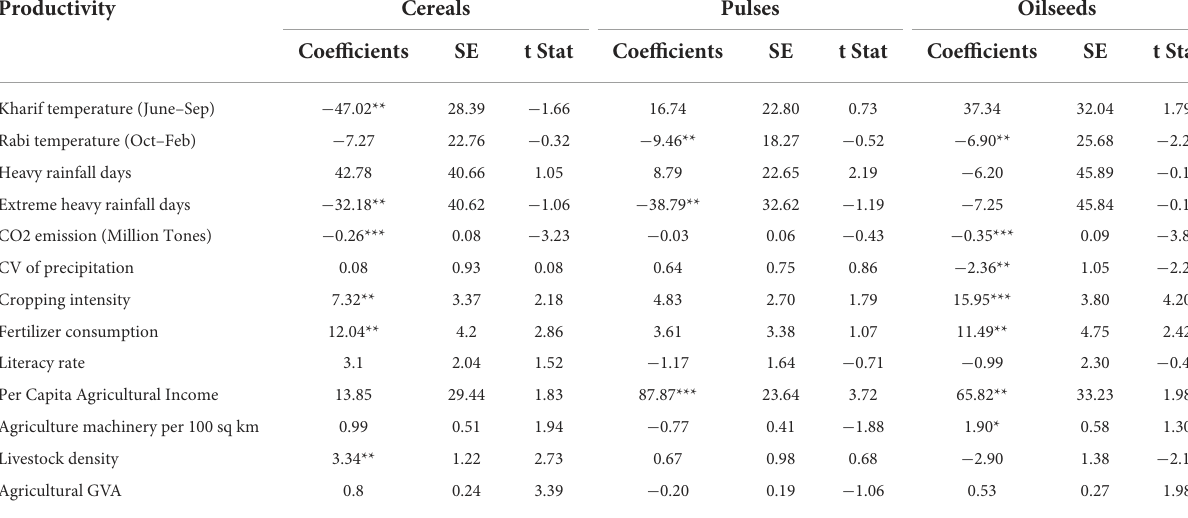
TABLE 2 Impact of change in climatic parameters on productivity of cereal, pulse and oilseed crops through Tobit regression model. Productivity Cereals Pulses